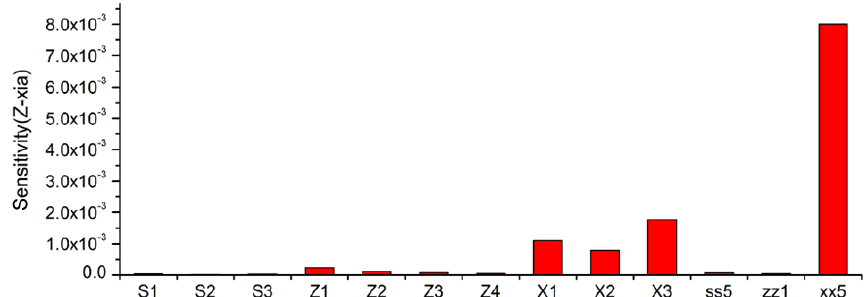
Figure 22. Sensitivity histogram of vertical ( Z ) deformation displacement of lower worktable.